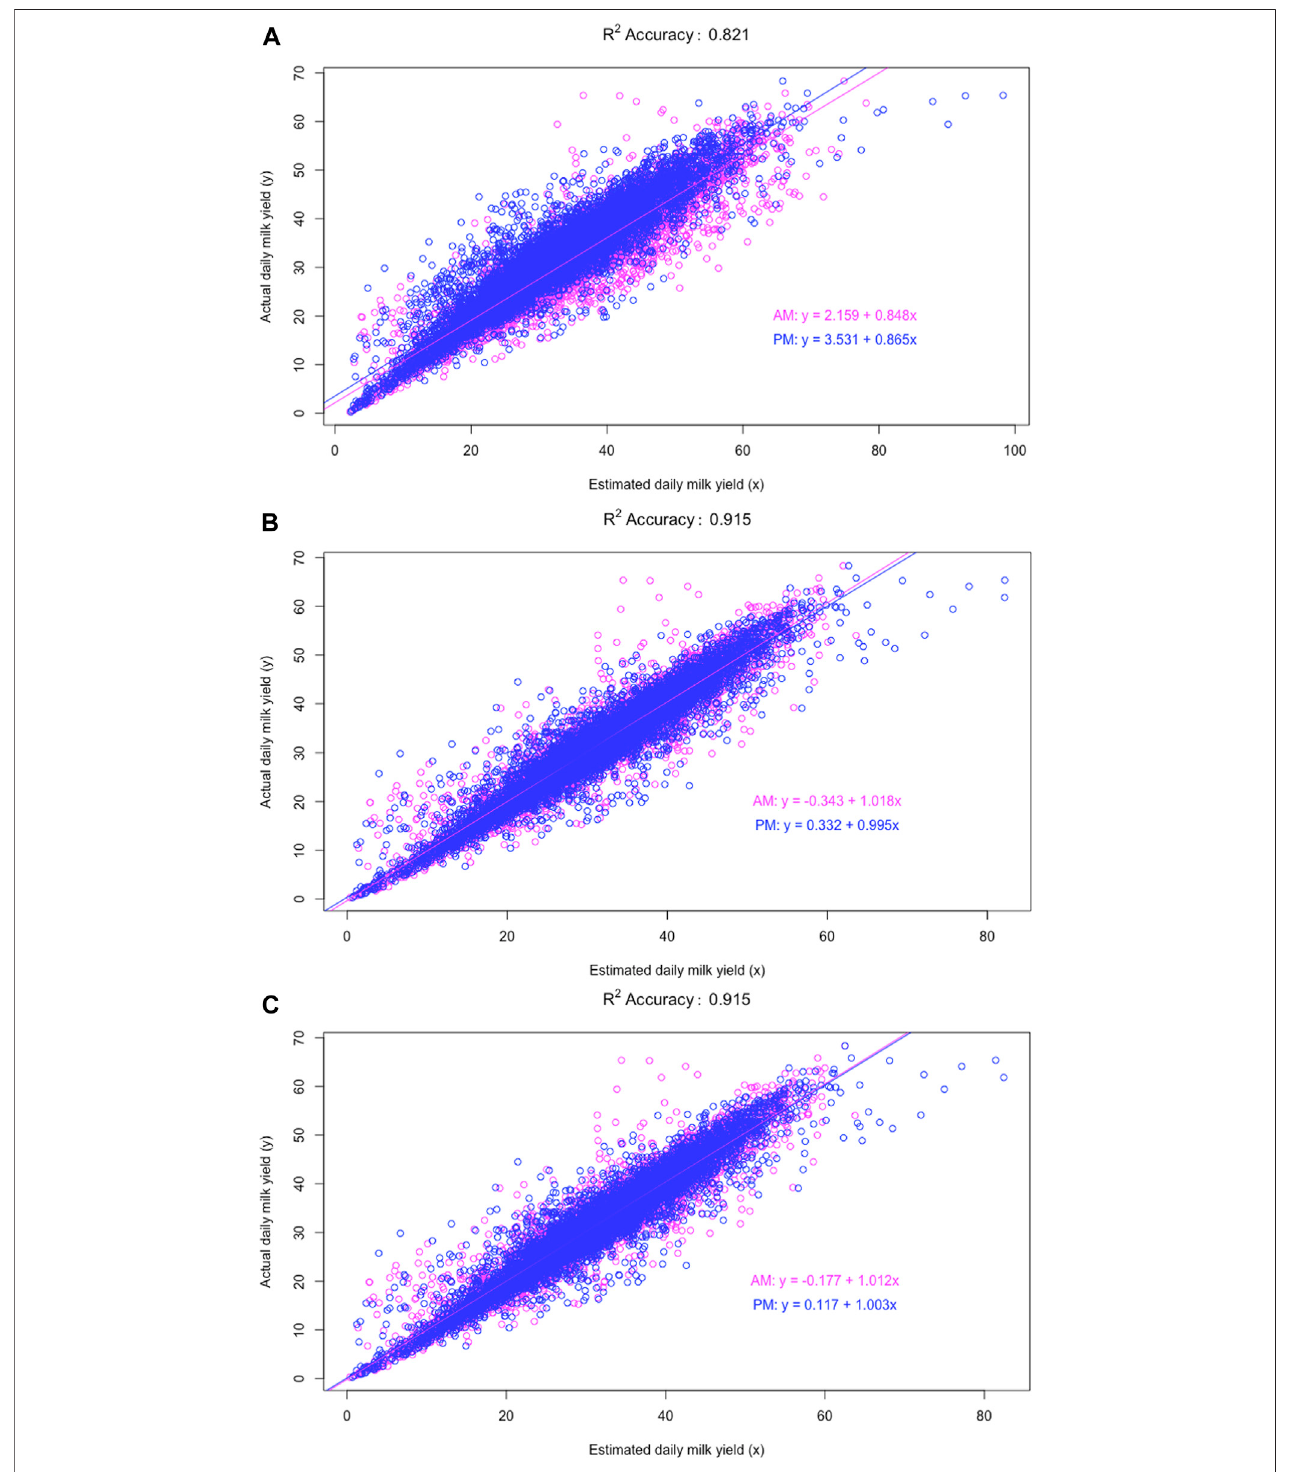
FIGURE5| Scatterplot and linearregression fi tsoftheactualdaily milkyield against estimated dailymilk yieldsunderthree scenarios: (A) estimating dailymilkyield (DMY) by doubling morning (AM) or evening (PM) milk yields (model M0); (B) estimating DMY for known morning (AM) and evening (PM) milkings separately using the exponentialregression model (model M8A; separateanalysis); (C) estimating DMYfor known AMand PM milkings jointly using the exponential regression model (model M8A; joint analysis).